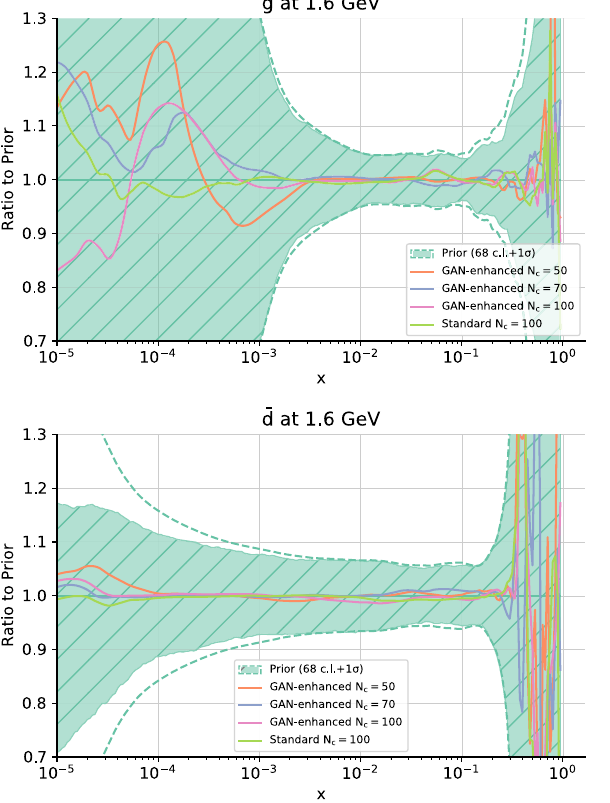
Fig. 8 Comparison of the PDF central values resulting from the GAN- enhanced compression for different values of N c = 50 , 70 , 100 and different PDF flavours ( g , s , ¯ d , ¯ s ) . Results are normalized to the central value of the prior set. The 68% c.l. is represented by the green hatched